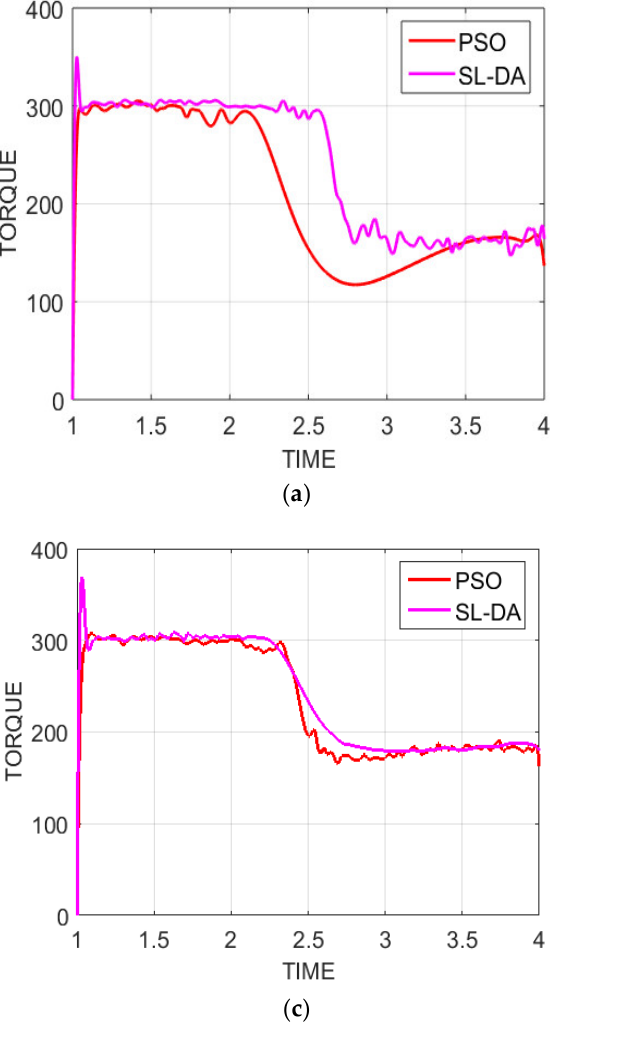
Figure 13. Torque analysis of proposed work over PSO: ( a ) speed 90 and torque 130; ( b ) speed 120 and torque 150; ( c ) speed 150 and torque 180; and ( d ) speed 180 and torque 200.